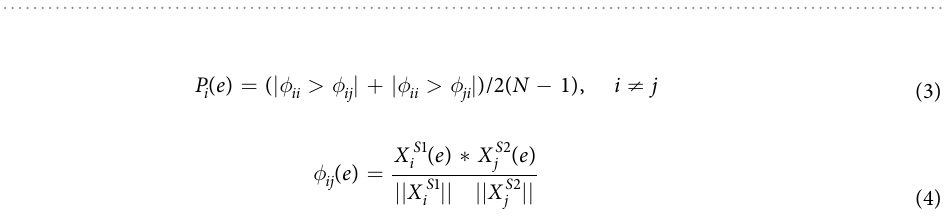
Table 1. Mean subject identification accuracy percentages and maximum number of misidentifications for 1000 program